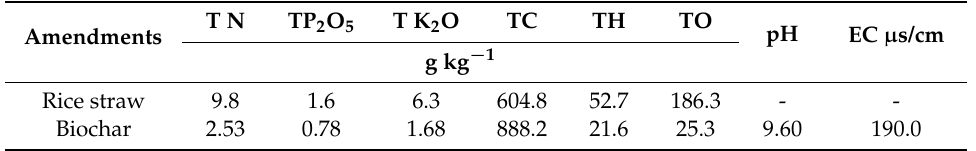
Table 2. Nutrient contents of the rice straw and